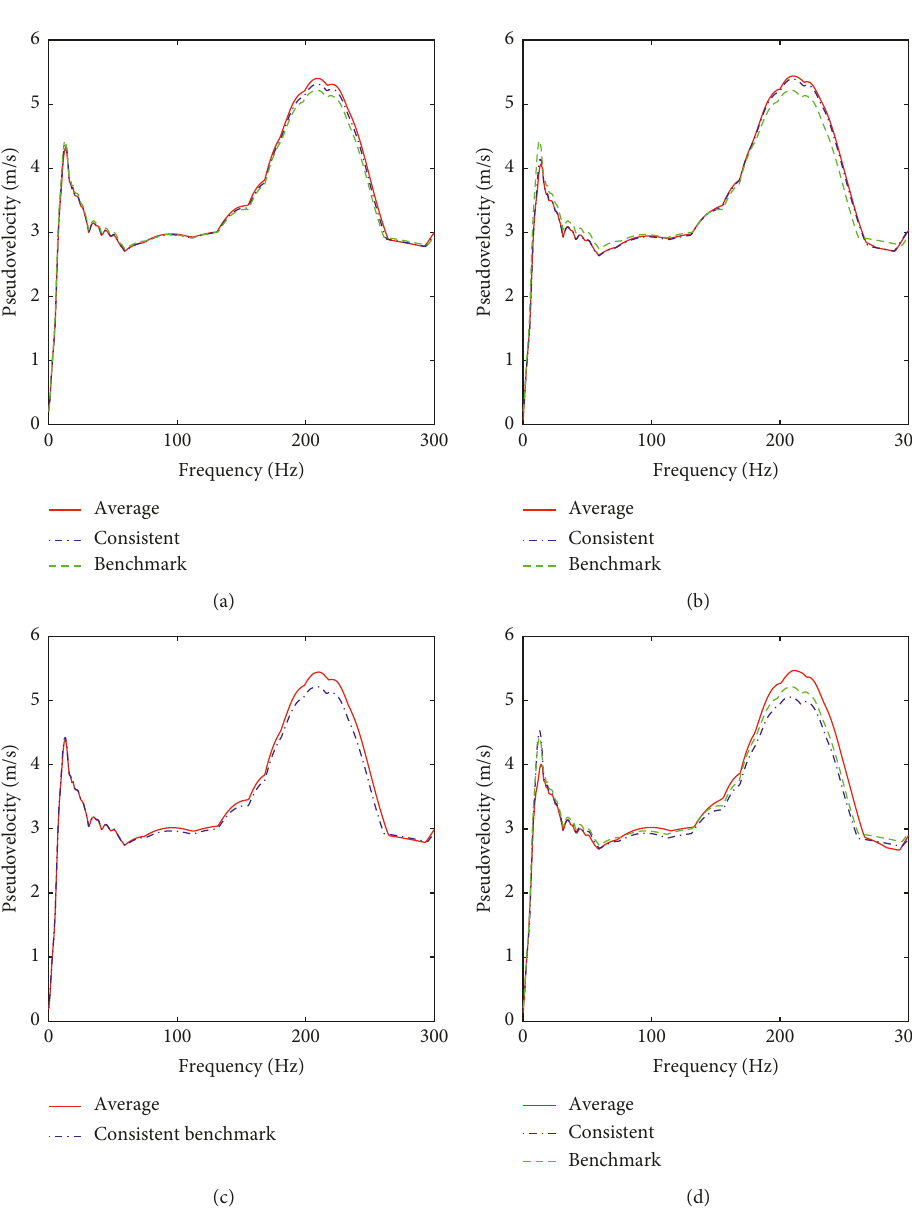
Figure 16: Shock response spectrum of cases 1 to 4. (a) Case 1. (b) Case 2. (c) Case 3. (d) Case 4.